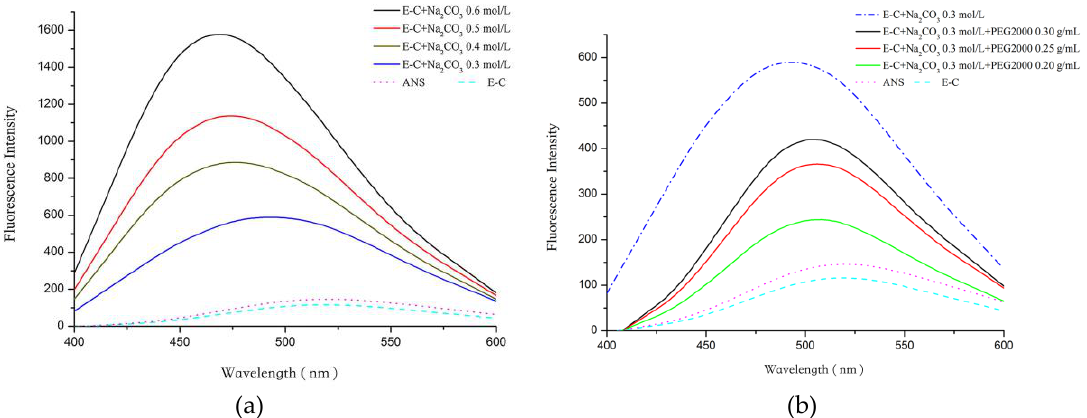
Figure 3. ( a ) ANS fluorescence characterization of Na 2 CO 3 –E-C interactions upon changes of Na 2 CO 3 concentrations from 0.3 to 0.6 mol/L; ( b ) ANS fluorescence characterization of PEG2000/Na 2 CO 3 –E-C concentrations from 0.3 to 0.6 mol / L; ( b ) ANS fluorescence characterization of PEG2000 / Na 2 CO 3 –E-C interactions upon. interactions